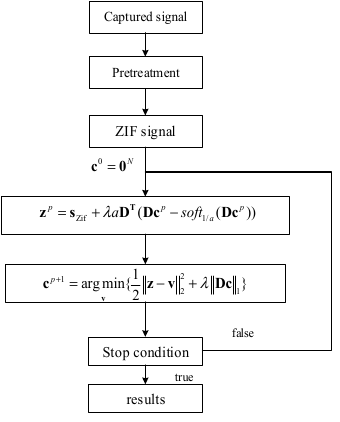
Figure 6. Flow chart of the NCTVR.